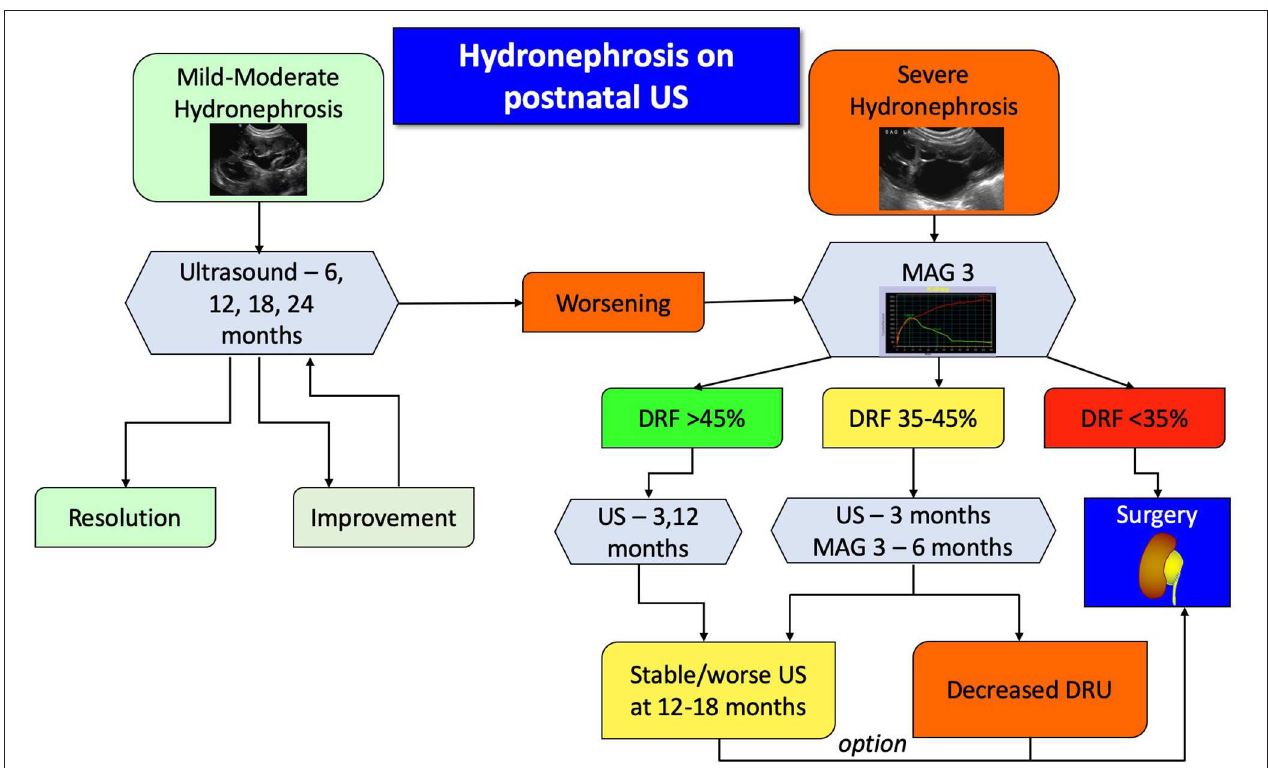
FIGURE 4 | Proposed algorithm for therapeutic approach to post-natal asymptomatic hydronephrosis. Antibiotic prophylaxis is recommended for severe hydronephrosis during the first year of